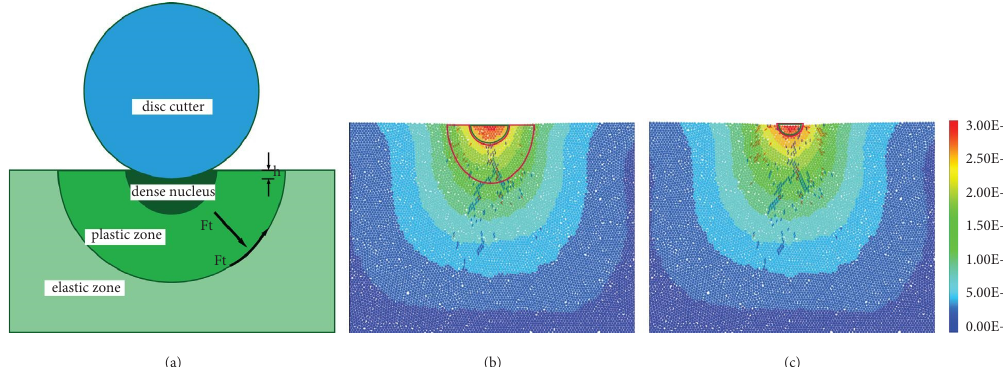
Figure 12: Internal stress and partition of rock: (a) internal partition of rock; (b) fractures and partition under single disc cutter; (c) fractures and partition assisted by ultrasonic vibration. Blue lines represent tensile cracks caused by compression and red lines represent tensile cracks by